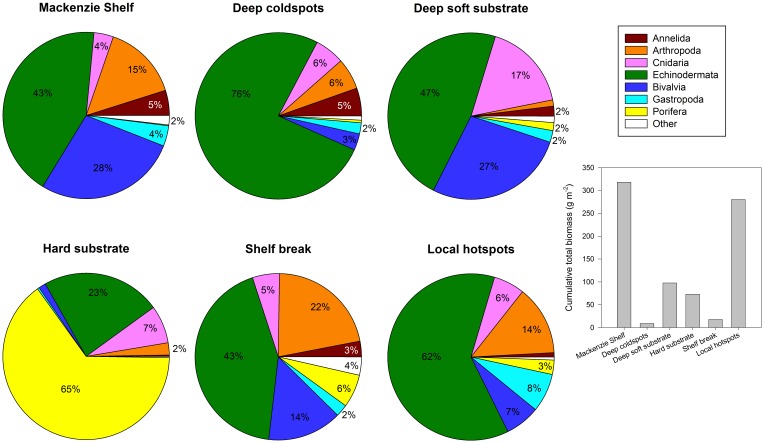
Variation in mean relative biomass composition (%; only≥2% shown) for the main phyla or classes sampled in all community clusters (pie charts) and cumulative total biomass (g m−2) sampled per community cluster (histogram).